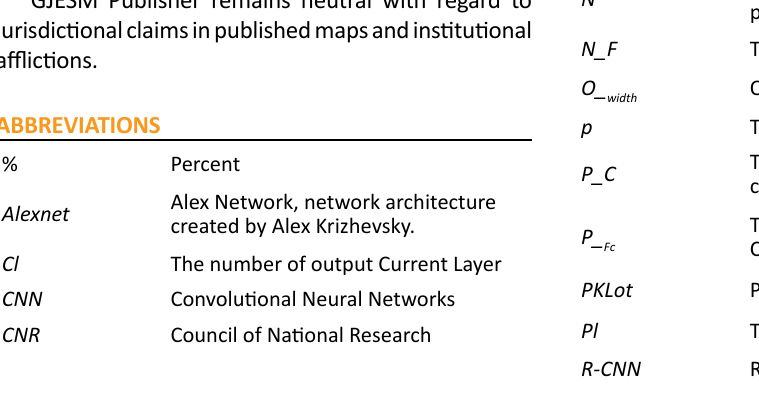
LeCun Network, convolutional neural network structure proposed by